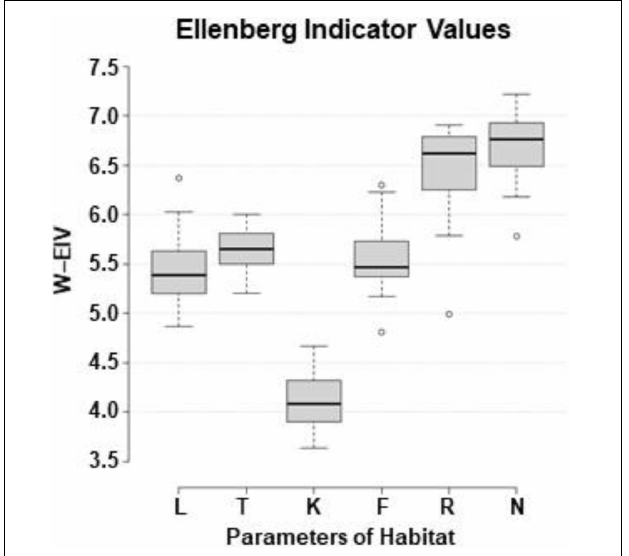
FIGURE 10 | Box-and-whisker plots of weighted Ellenberg indicator values (W-EIV) of herbaceous species in the sites with Impatiens parviflora (W-EIV: L, light; T, temperature; K, continentality; F, soil moisture; R, soil reaction; N, soil nutrients). The central line of each box indicates the median value; the boxes, the lower (25%) and upper (75%) quartiles, and the whiskers, are from 10 to 90 percentiles (typical range), the points are outliers.